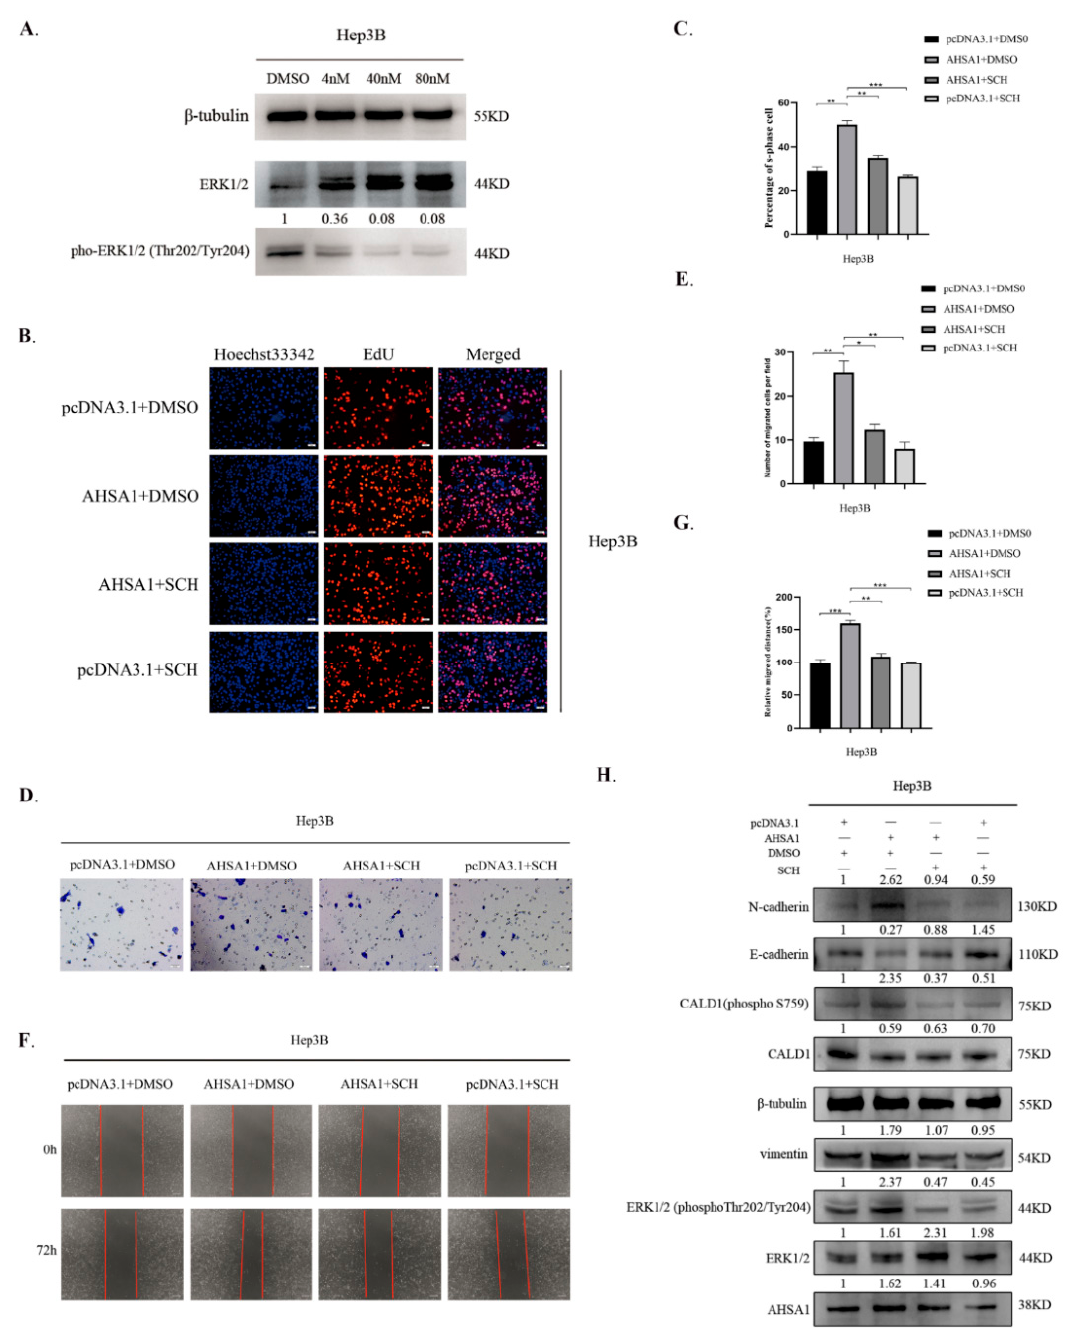
Figure 5. Inhibition of ERK1/2 phosphorylation reversed the HCC cell proliferation and EMT that was promoted by AHSA1 overexpression ( A ). The inhibitory efficiency of different concentrations of SCH772984 on Hep3B cells was analyzed by Western blot. ( B , C ). Representative images and quantitative analysis of EdU staining showed that SCH772984 reversed the proliferation induced by overexpression of AHSA1 in Hep3B cells. ( D – G ). Representative images and quantitative analysis of Transwell and wound healing assays showed that SCH772984 reversed the migration induced by overexpression of AHSA1 in Hep3B cells. ( H ). The changes in protein expression after inhibiting ERK1/2 phosphorylation in Hep3B cells that overexpressed AHSA1 were detected by Western blot. *, p < 0.05; **, p < 0.01; ***, p < 0.001. The uncropped blots are shown in Supplementary